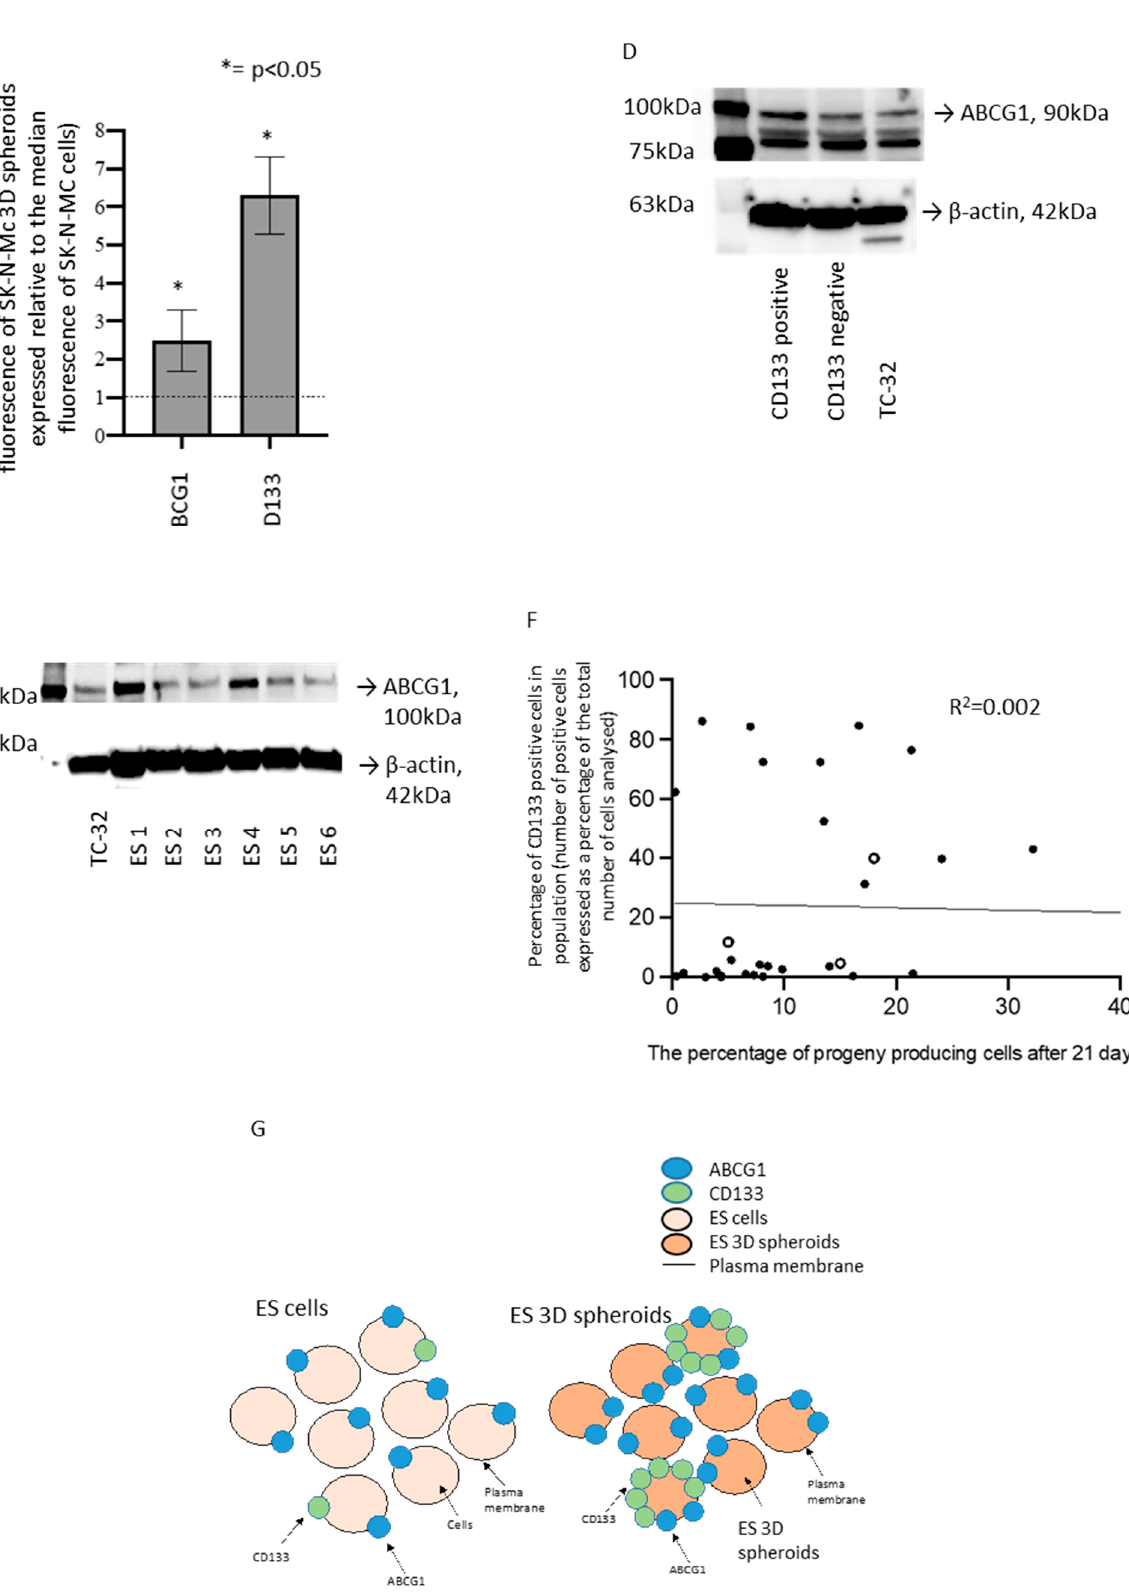
Figure 6. Expression profile of ABCG1, CD133 and MRP1 in ES cell lines and patient-derived cells. ( A ) The percentage of SK-N-MC cells grown in 2D and 3D cultures expressing ABCG1 and CD133 was quantified by flow cytometry; 10,000 events were examined for each condition. The percentage of positive cells is presented as the mean ± SEM ( n = 6). ABCG1 and CD133 expression in SK-N-MC cells grown in 2D and 3D cultures was compared using a non-parametric Mann–Whitney two-tailed